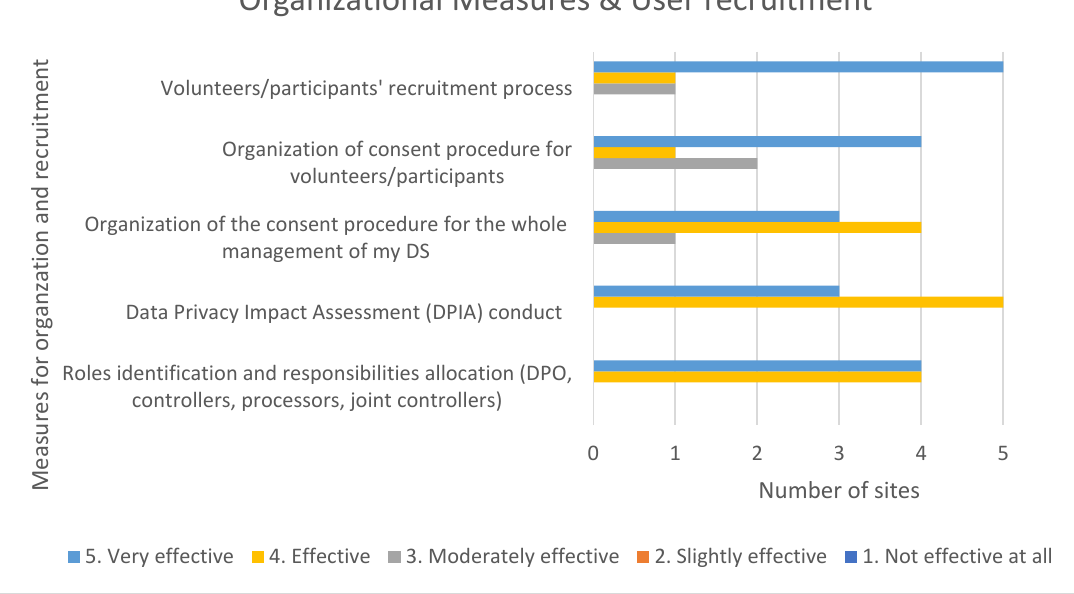
Figure 6. Organizational measures and user recruitment.